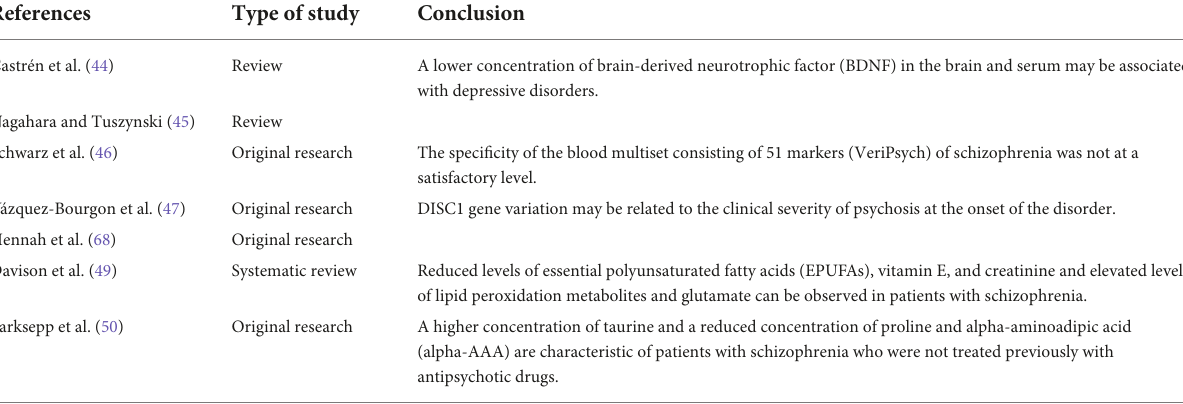
TABLE 4 Current knowledge about the possibility of using biochemical and molecular markers in